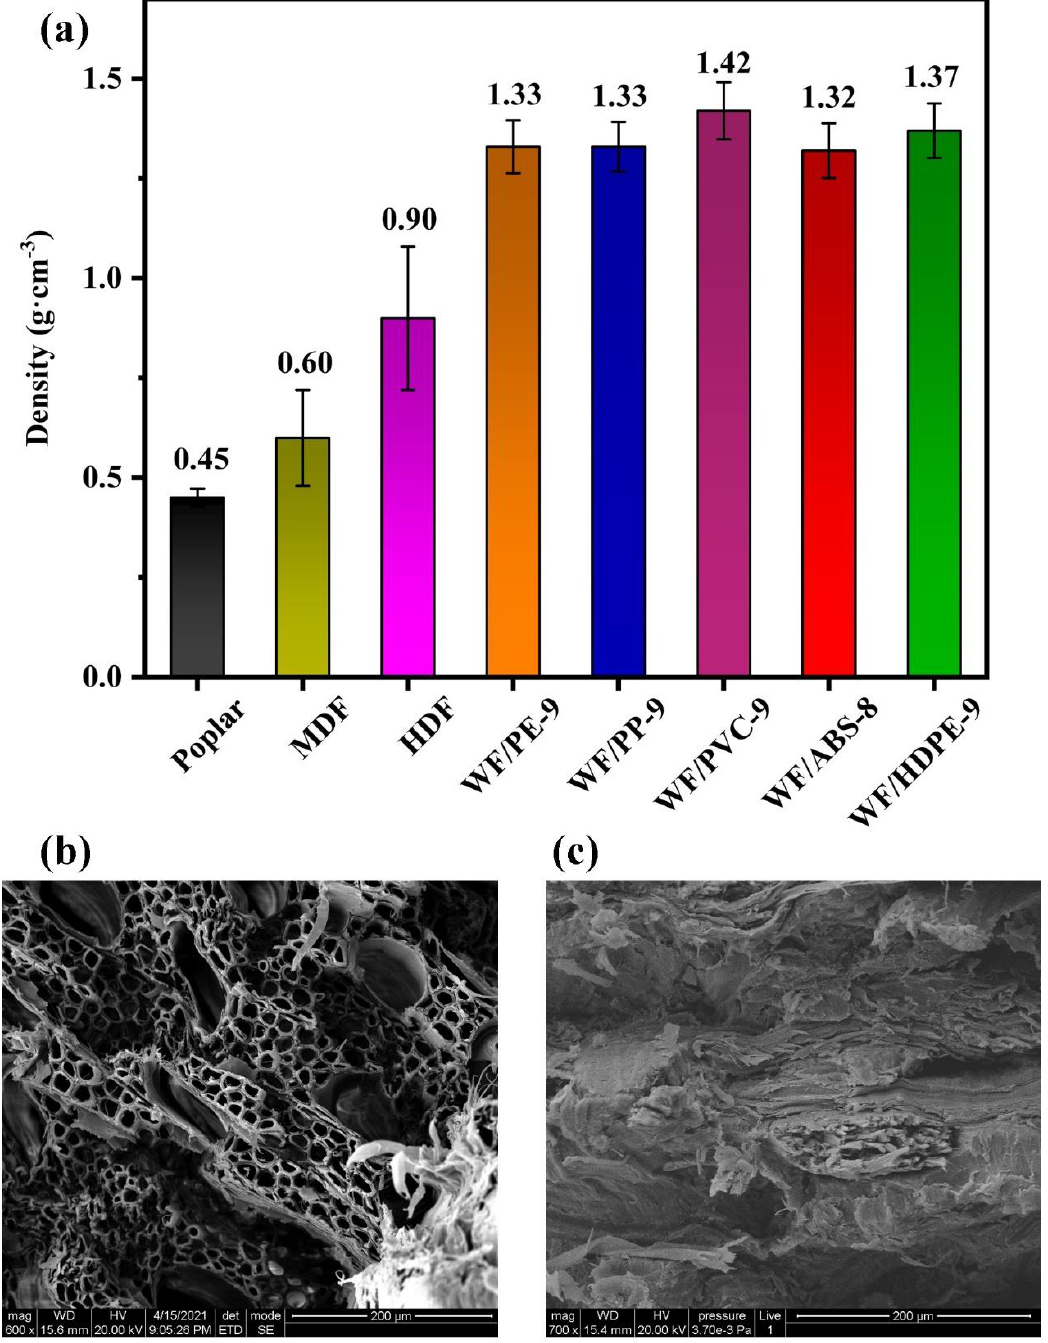
Figure 2. ( a ) Density of poplar, MDF, HDF and WPC. ( b ) Microscopic image of the cross-section of poplar. ( c ) Microscopic image of the cross-section of